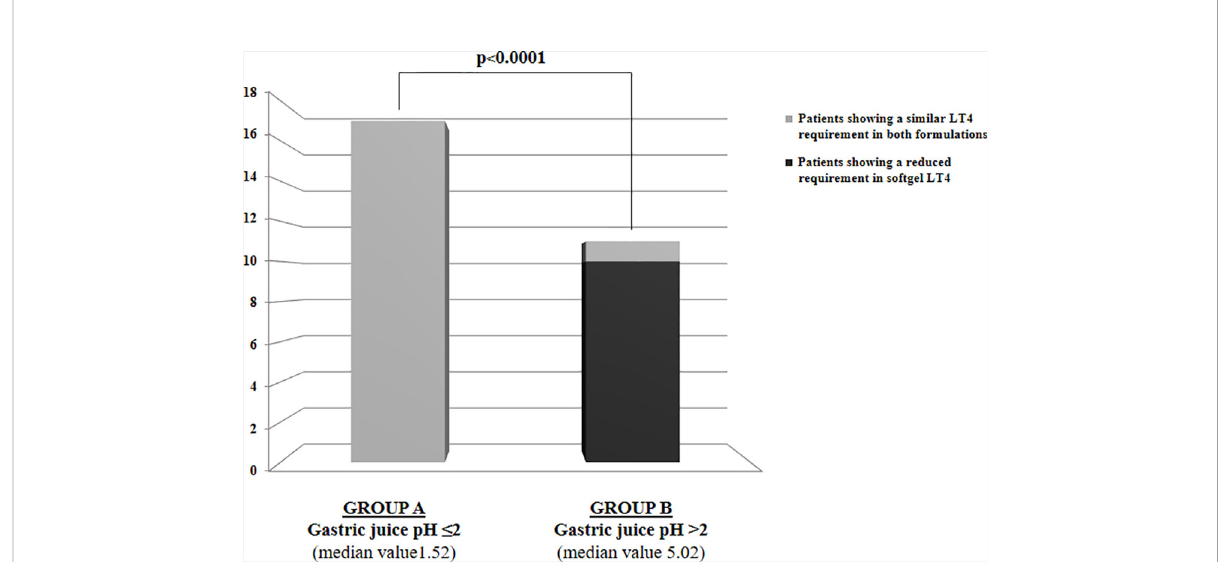
FIGURE 2 LT4 requirement variations following the switch to softgel formulation in the whole sample of patients subdivided in two groups based on gastric juice pH: Group A with gastric juice pH ≤ 2 and Group B with gastric juice